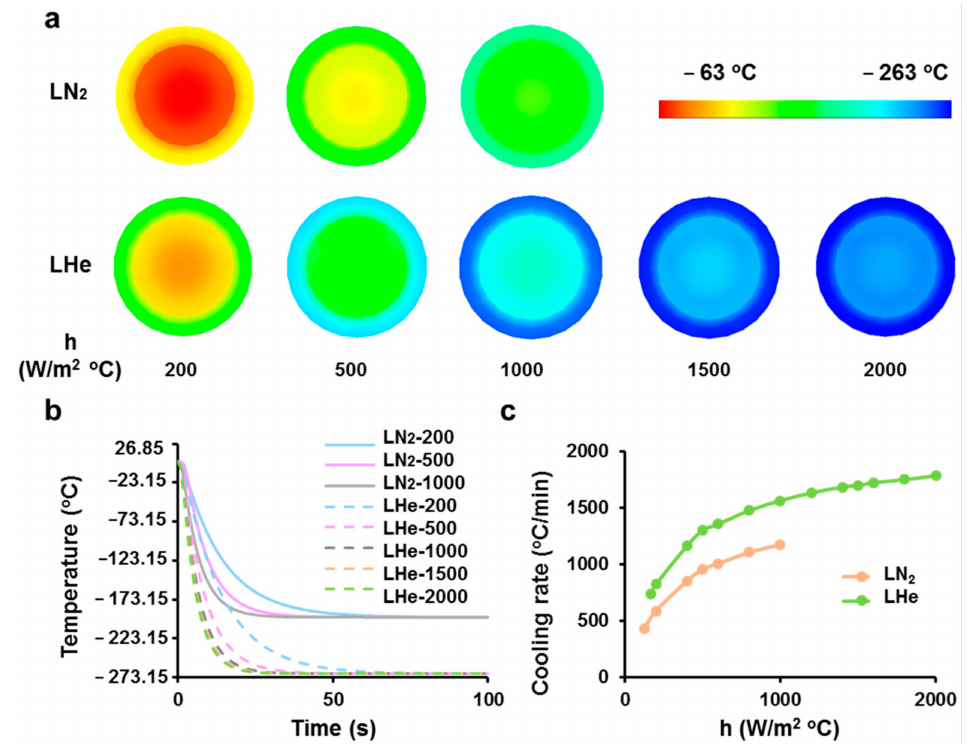
Figure 2. Theoretical prediction for cooling processes of vitrification straws plunged into LN 2 or LHe. ( a ) Temperature contours of the midplanes of water-filled straws after immersing into LN 2 or LHe for 3.2 s at different heat transfer coefficients. ( b ) Thermal histories of the midpoints of cell- suspension-filled straws immersed into LN 2 or LHe at different heat transfer coefficients. ( c ) Effect of heat transfer coefficients on cooling rates at the midpoints of cell-suspension-filled straws from 4 ◦ C to − 90 ◦ C when plunged into LN 2 or